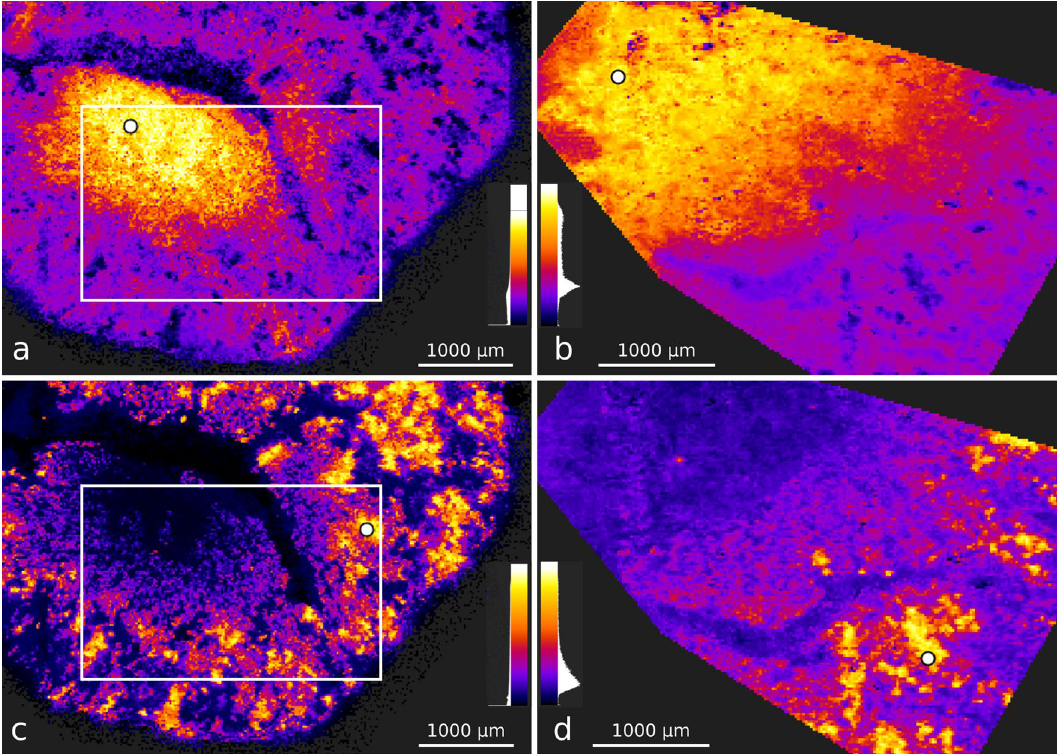
O I t I O I t k and k . k ( a , c ) and k ( b , d ) show similar t k measurement in ( b ) and ( d ),